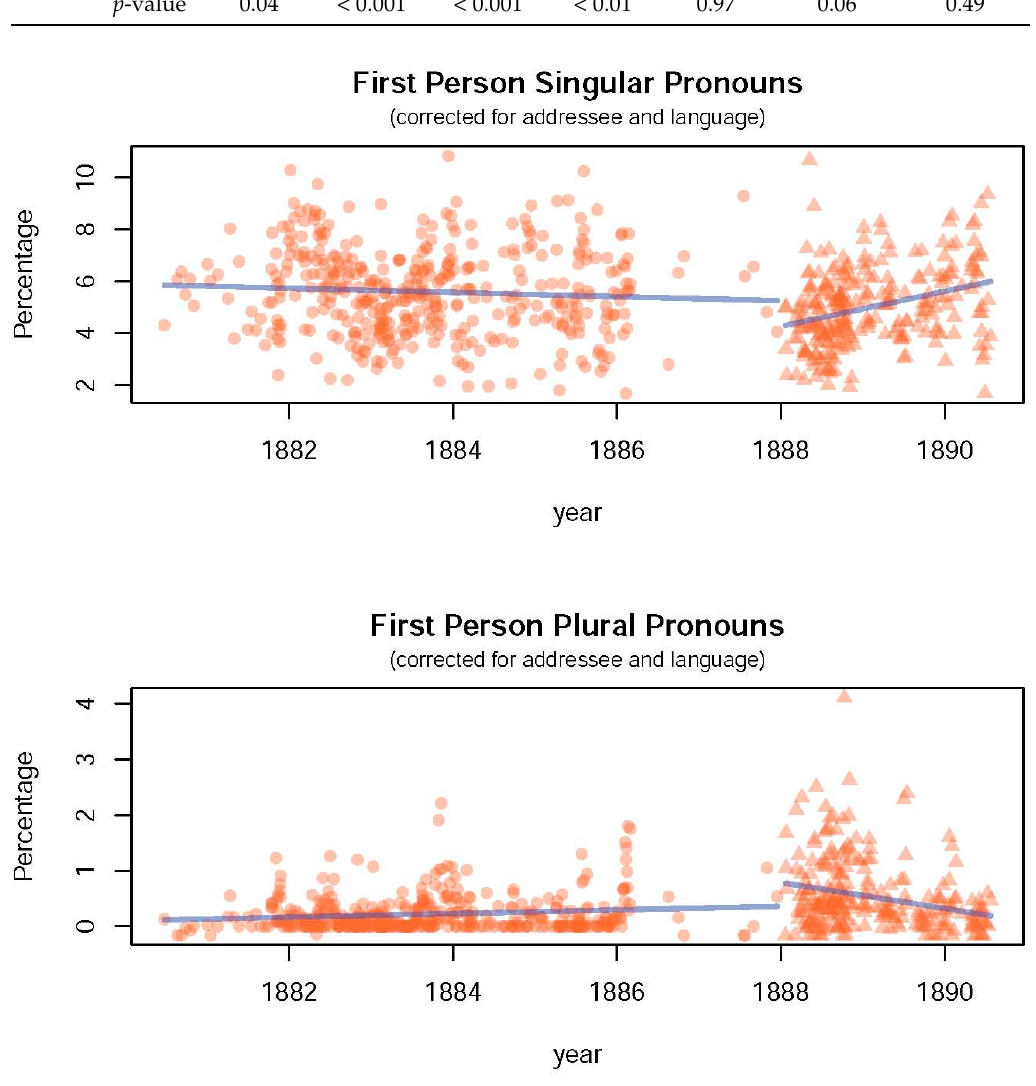
Figure 1. Percentage of first person singular pronouns and first person plural pronouns per letter (corrected for addressee and language). Blue lines represent trends before (dots) and after (triangles) Van Gogh’s move to Arles.